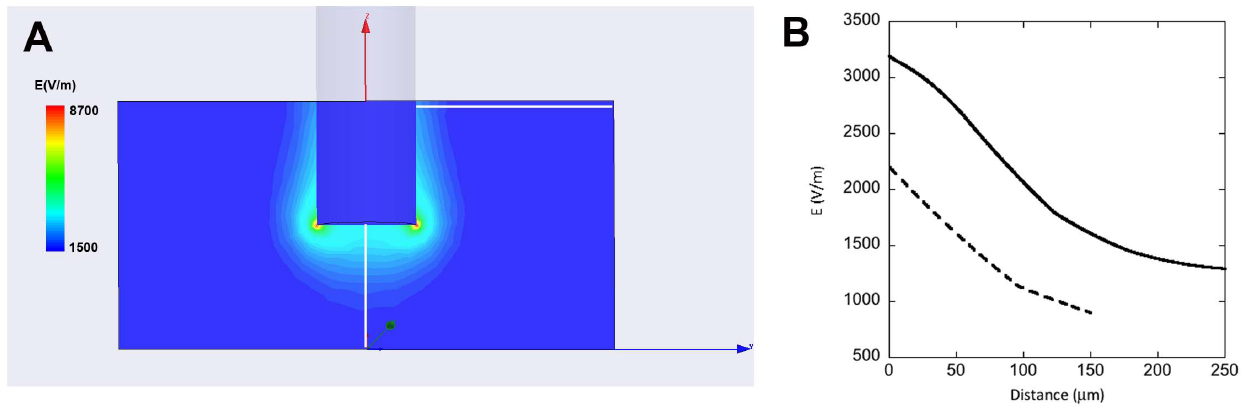
Figure 7. 3D finite element model of the cylindrical electrode geometry used in this study performed in pure water and for an applied potential of 1 V. A) equipotentials around a cylindrical electrode in a plane going through the centre of the cylinder. B) Electric field as a function of distance from the electrode surface taken along the two white lines in A). The solid line corresponds to the white line at the end of the electrode and the broken line corresponds to the white line perpendicular to the side of the